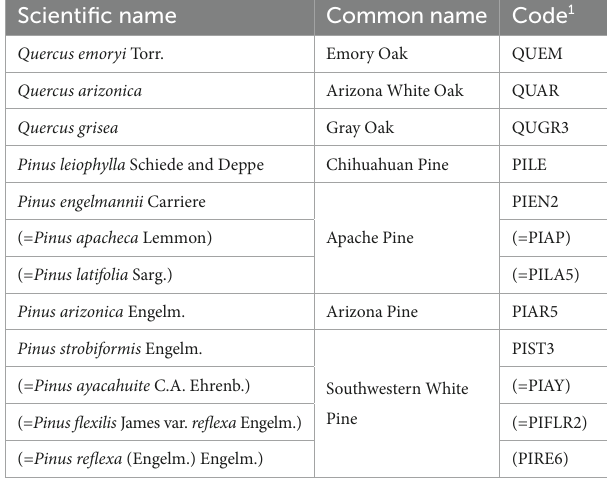
TABLE 1 Scientific name, common name, and species code of the seven tree species of interest.